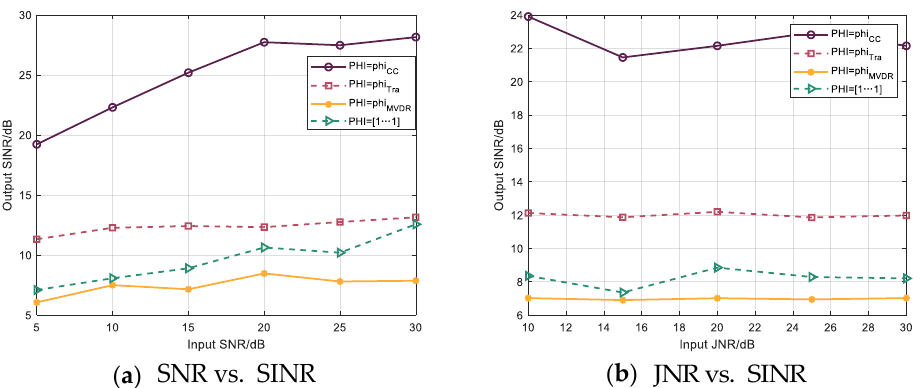
Figure 4. The anti-jamming performance of the CC algorithm compared with the traversal search algorithm, MVDR, and homogeneous array antennas. ( a ) SNR. ( b ) JNR.